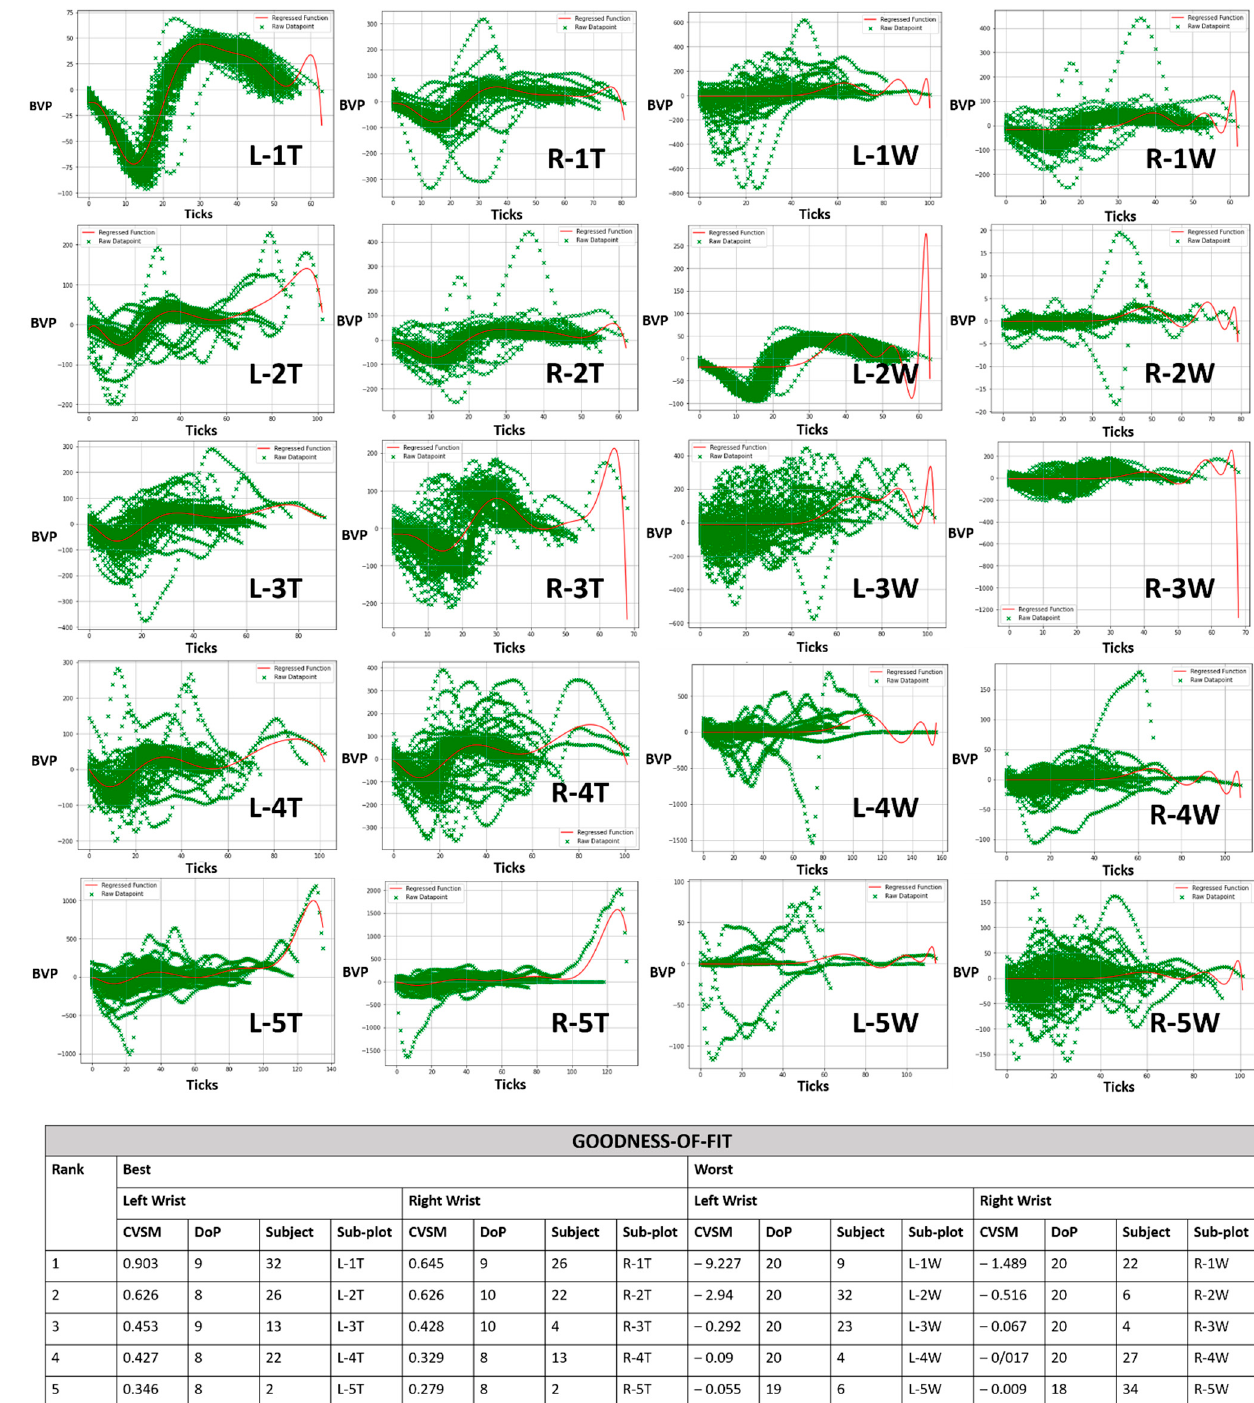
Figure 3. Goodness-of-fit of pre-journey (PJ) datasets ranked by top five and worst five CVSMs. Each sub-plot consists of an Empatica E4 wristband’s blood volume pressure sensor value (BVP) versus ticks (sensor time interval). [Left wrist = L and right wrist = R].